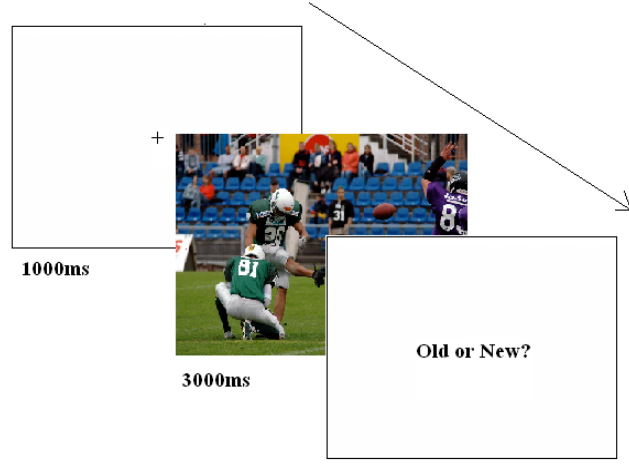
Figure 3: A diagrammatic representation of the recogni- tion memory test in the ‘imagery prior to recognition’